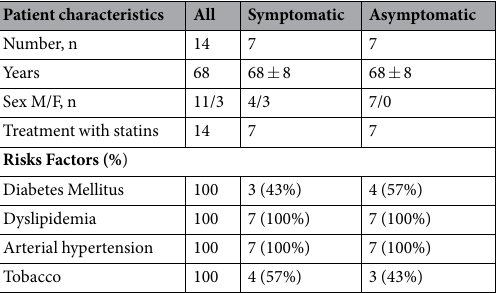
Table 3. Demographic data for Basurto University Hospital cohort of